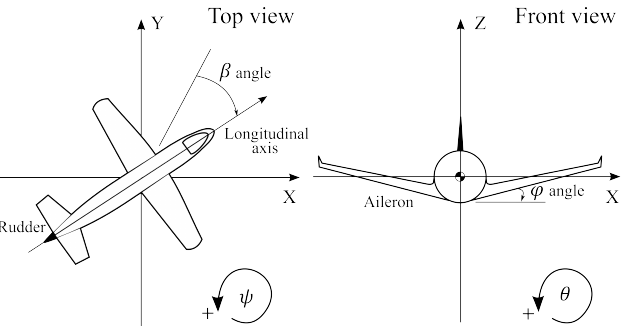
Figure 2. Jet transport aircraft.